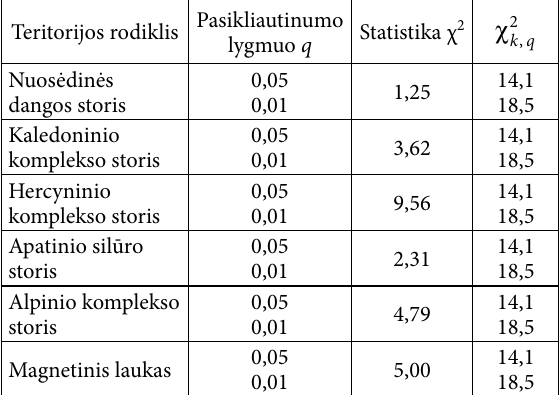
Table 2. Examination of correlation coefficients dependence on general correlative